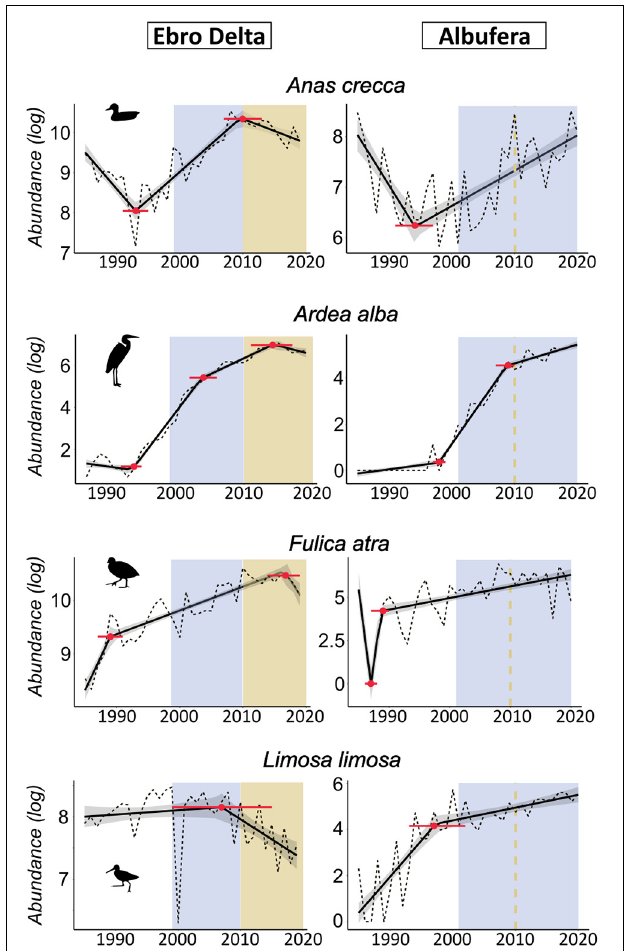
FIGURE 3 | Estimated trends in waterbird abundance and years of change. The dotted lines show the annual censuses of four species in the Ebro Delta and l’Albufera (left and right plots, respectively). The solid black line and gray shading, respectively, indicate the estimated abundance trends in each period and their uncertainty. The red dot indicates the estimated year in which the abundance trend changed (i.e., significant break point identified), while the red line represents its associated uncertainty. The blue and brown backgrounds, respectively, indicate the AES flooding period and no AES flooding period. As the cessation of the flooding was only conducted in the Ebro Delta to control the invasion by apple snail, in the plots of the l’Albufera (right side) there is only one blue background, but with a vertical dashed brown line indicating the year when the no AES flooding period started in the Ebro Delta. See Supplementary Figure 1 for details of all species.